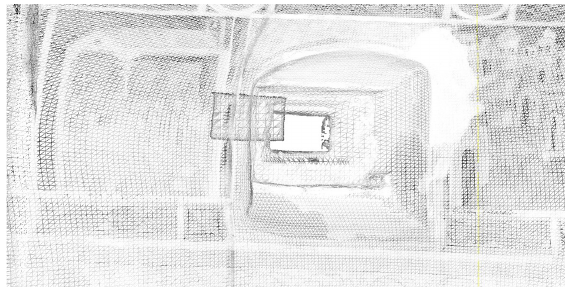
Figure 4. Multi-resolution grid algorithm allowed to reconstruct the entire numerical model according to different resolution.